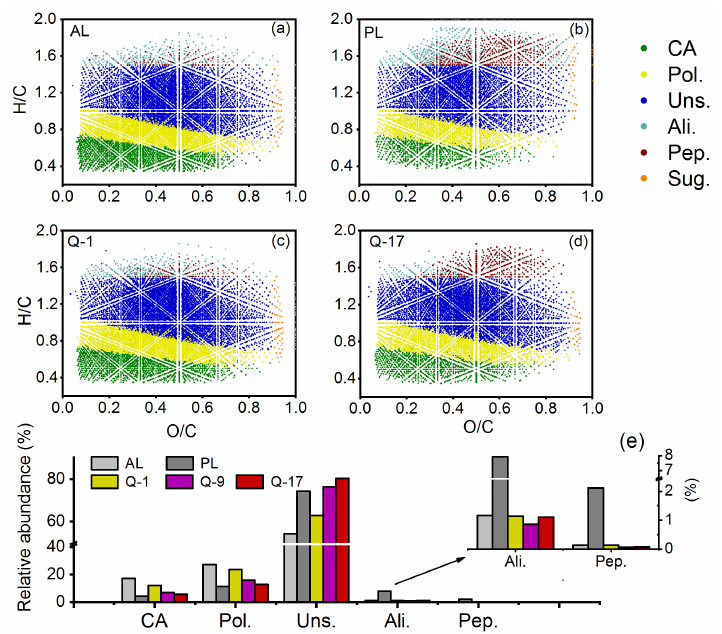
Figure 5. van Krevelen diagrams of AL leachate DOM (a) , PL leachate DOM (b) , headstream DOM Q-1 (c) , downstream DOM Q-17 (d) and the relative abundance of defined compound class in different samples (e) . CA denotes condensed aromatics, Pol. denotes polyphenols, Uns. denotes highly unsaturated compounds, Ali. denotes aliphatics, Pep. denotes peptides; and Sug. denotes sugar. The van Krevelen plots of AL and PL leachate DOM were modified from Wang et al. (2018).